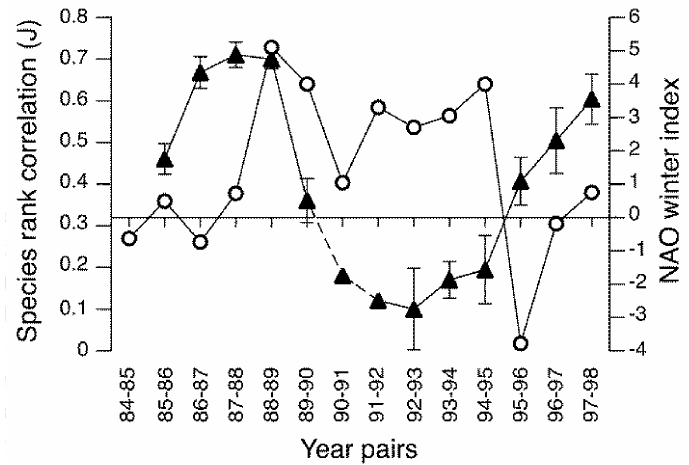
Figure 3. Year-to-year changes in the persistence of freshwater invertebrate communities (closed triangles, mean ± standard error (SE)) in eight streams of the Llyn Brianne catchments, Wales U.K., between 1985 and 1998. Persistence calculated as Spearman’s correlation (J) between the rank abundances of species in adjacent years. Dashed lines indicate missing data interpolated for 1991. Circles indicate the North Atlantic Oscillation (NAO) winter index. Redrawn from